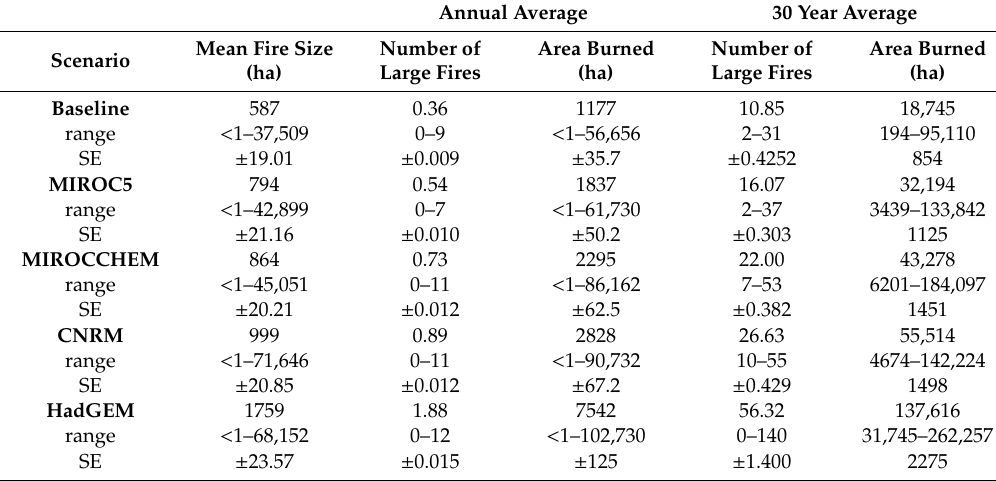
Table 2. Simulated mean fire size of all fires and the mean annual number of large fires, fires greater than 100 ha. Range and standard error are shown below mean values. Conditional area burned is the size of the study area e ff ected in those years that fires were simulated—not all years experienced fire. 30-year area burned is the estimated cumulative extent of wildfire between 2040–2069. Mid-century fire size and frequency distributions were compared to baseline distributions using Dunn’s tests and in all instances, mid-century distributions were significantly di ff erent from baseline (all p < 0.0001).